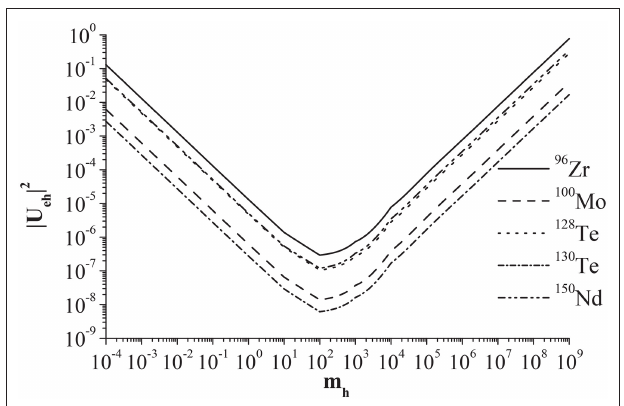
ν e mixing matrix element −